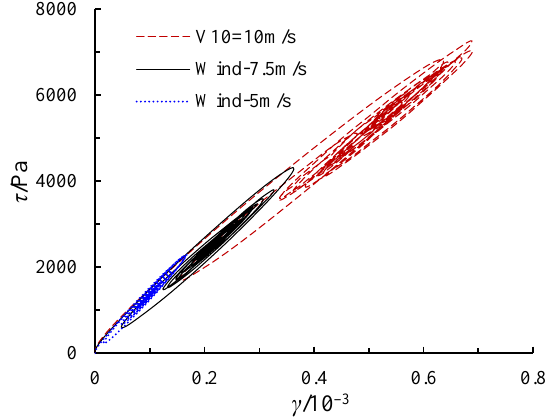
Figure 14. Soil stress–strain curves around the GBF for different wind loads.